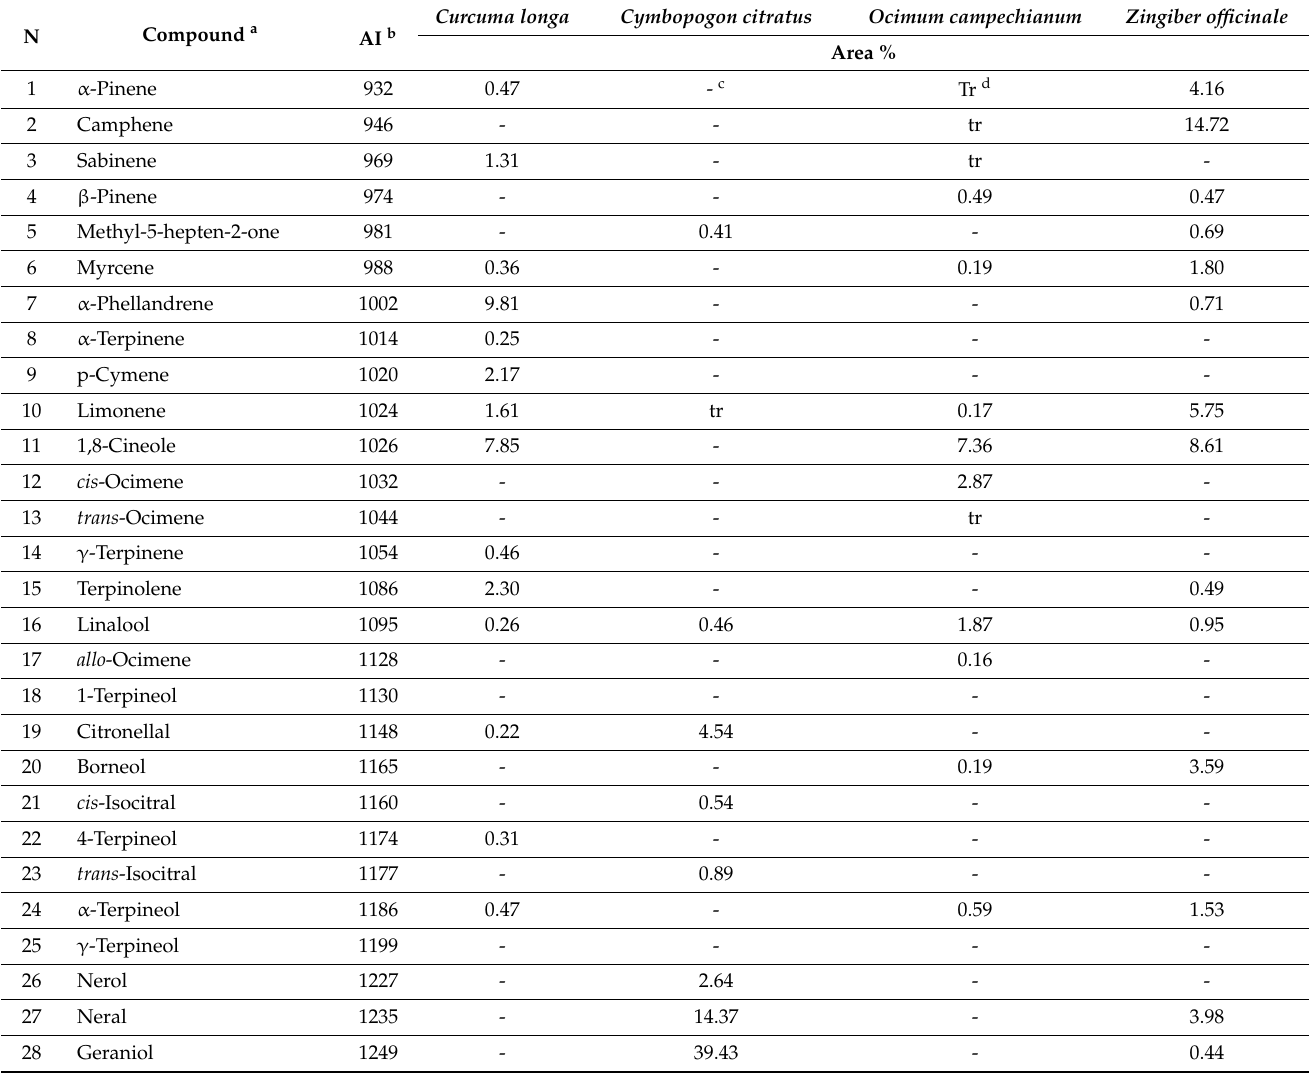
Table 2. Chemical composition of essential oils (EOs) from studied species through GC and